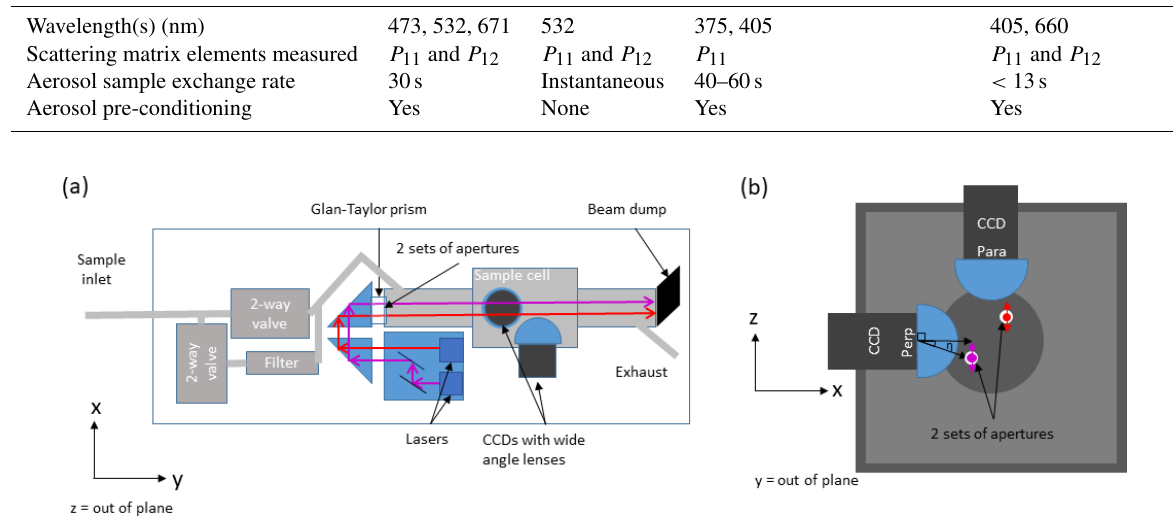
Figure 1. Geometry of laser imaging nephelometer. (a) Simplified schematic showing the sample flow and laser paths. (b) Schematic of the aerosol sample cell indicating the optical geometry of the wide-angle lenses and both lasers, including the scattering plane rotation angle ( η ). The cameras are identified by their orientation relative to the laser polarization, either parallel or